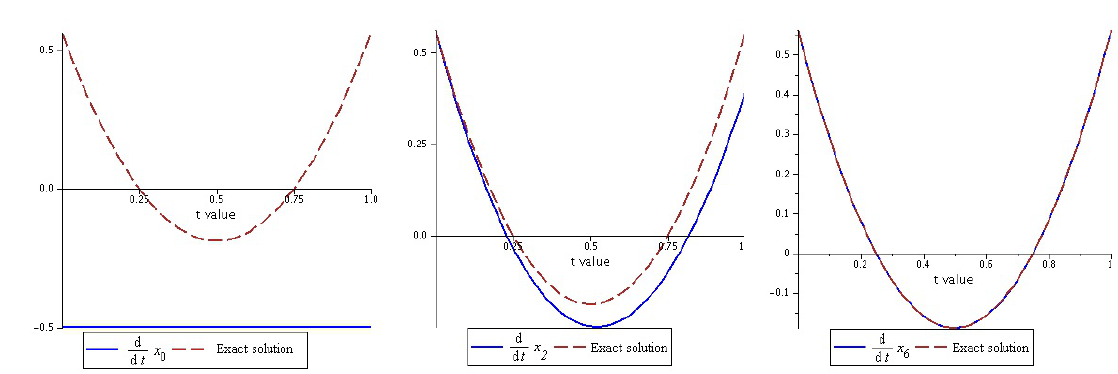
Figure 4: Graphs of x (cid:48) n and derivative of exact